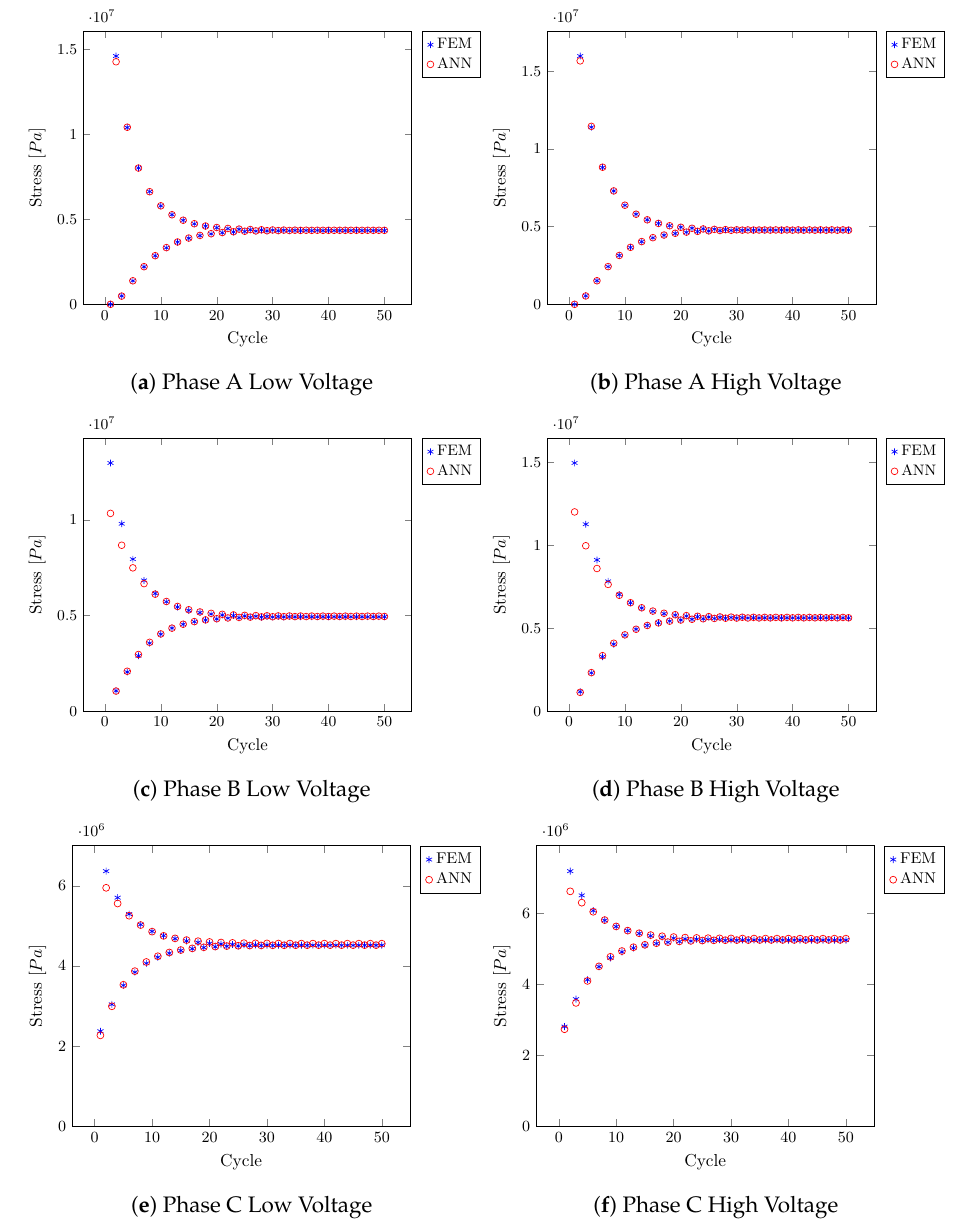
Figure 17. FEM and ANN simulations for a fault impedance of R = 1 Ω and X L = 15 Ω . Table 9 presents the mean absolute percentage error for the foregoing cases. The model has the least error when the fault is at the terminals of the power transformer. As long as the fault is farther away, the error increases. In each case, the error is greater when the stress is lower. This behavior agrees with the training characteristics of ANNs that are more influenced by higher values than by lower